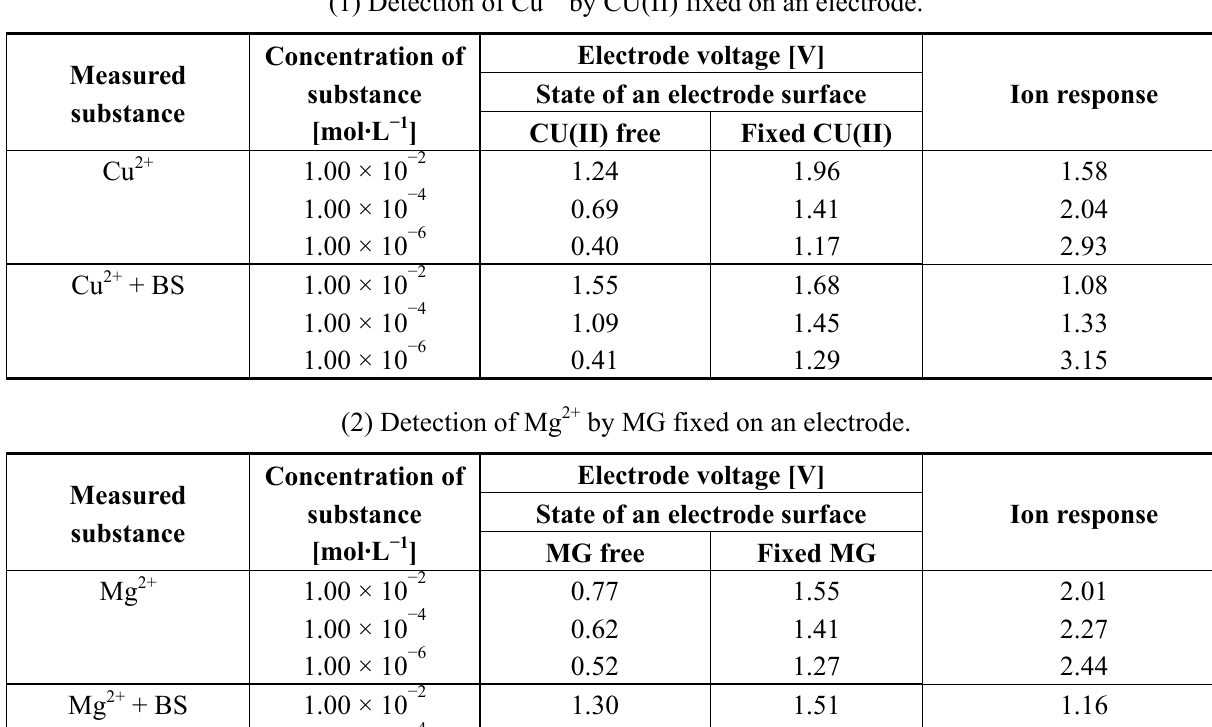
Table 2. Detected electrode voltages from host-guest reactions (Type